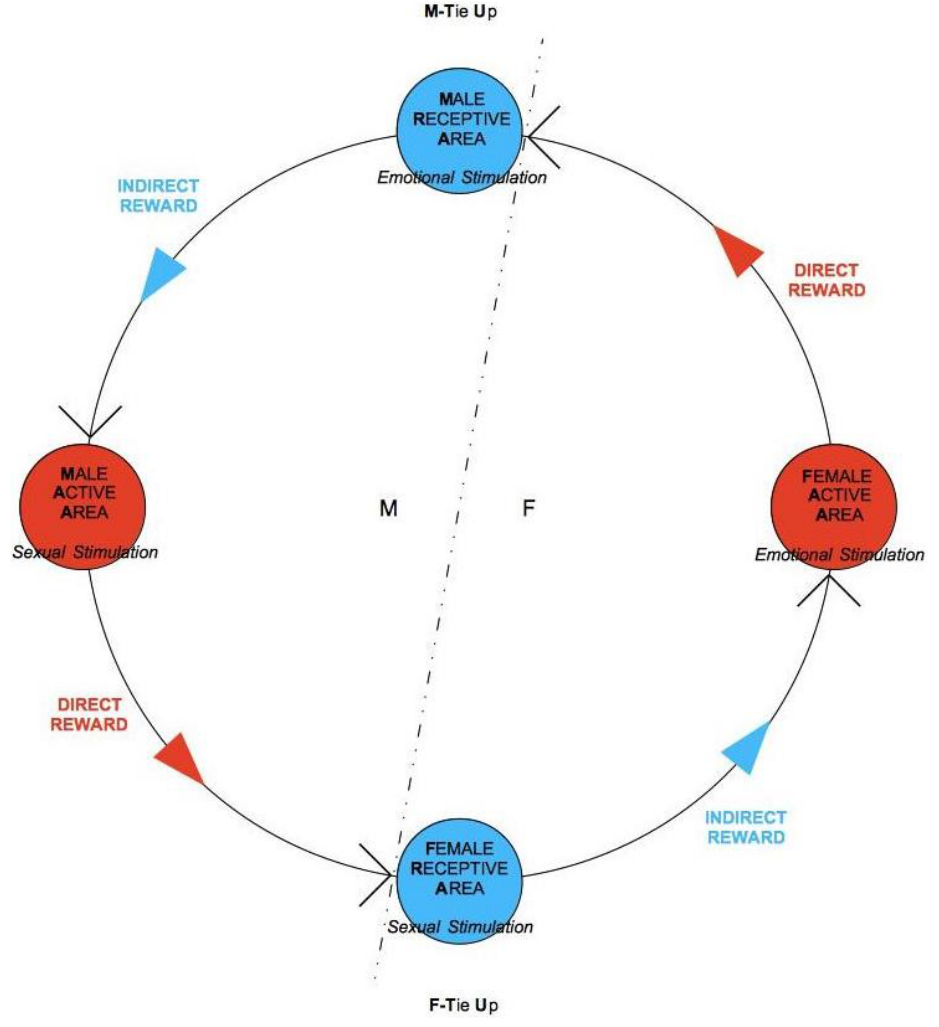
Figure 6. The Tie-Up Cycle (TU-C) diagram.